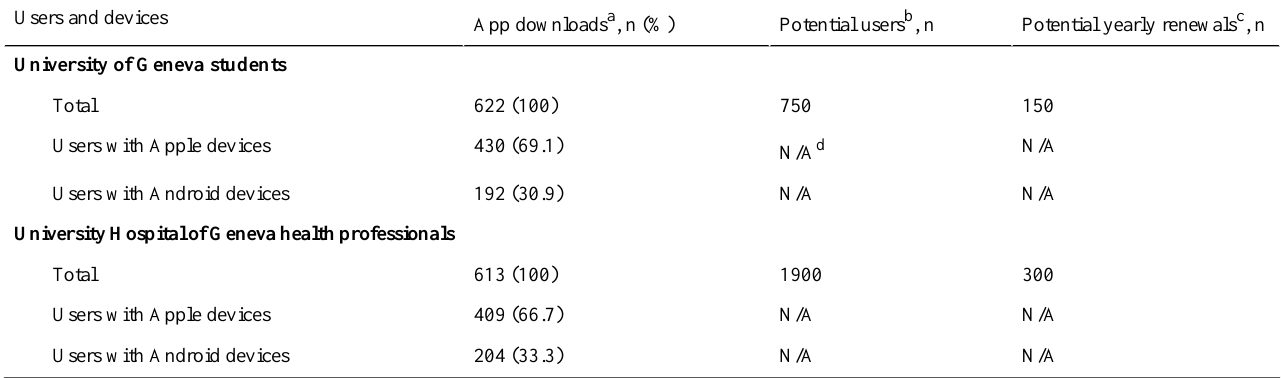
Table 1. User distribution between university students and hospital medical personnel since the launch of the final version of the HeadToToe platform in March